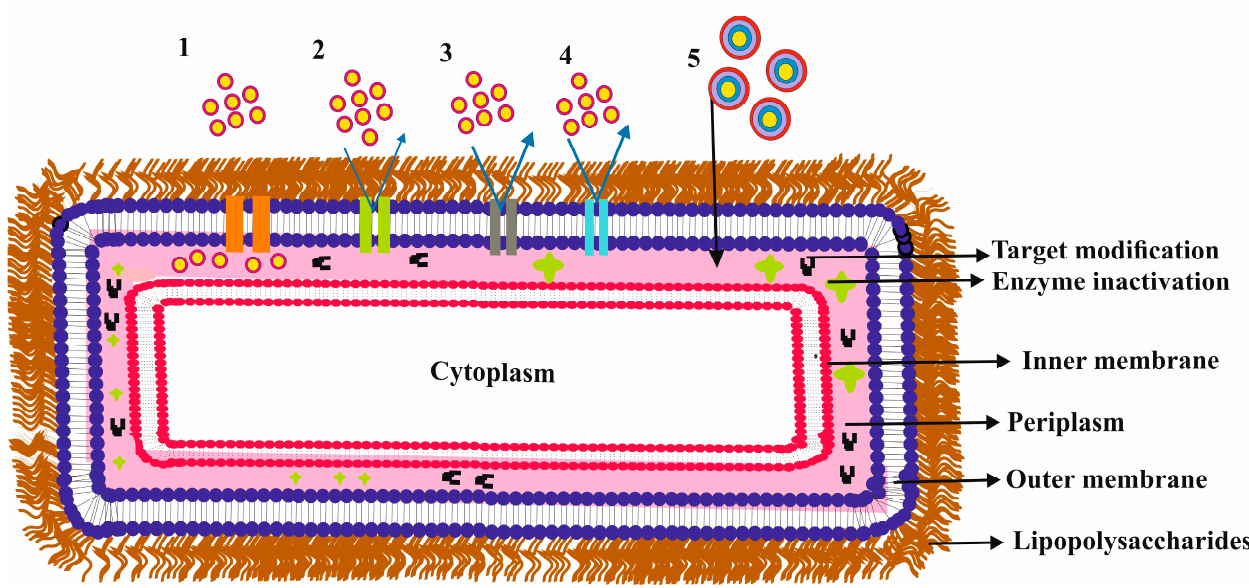
Figure 1. Several systems pertaining to antibiotic/antimicrobial resistance that Gram-negative bacteria may be utilized as an overview (structural interpretation) and antibiotic/antimicrobial resistance mechanism correlated with outer membrane proteins modification. 1. Solute transport via outer membrane proteins, 2. Loss of functional outer membrane proteins, 3. Modification of outer membrane proteins, 4. Expression of constricted outer membrane proteins, 5. Partitioning of hydrophobic molecules via the outer layer.